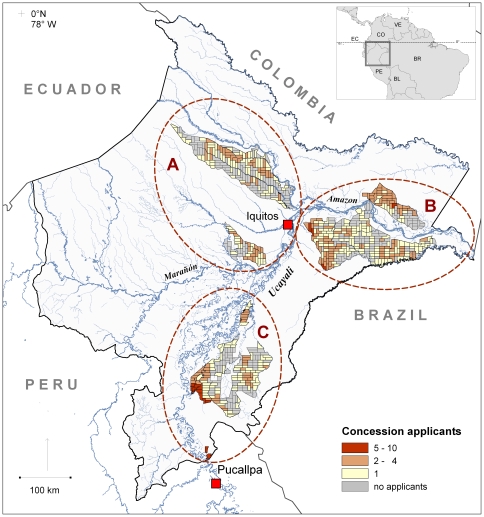
Forest concession units in Loreto, and the number of tenders (concession dapplicants) they received in the allocation process 2004.The cities of Iquitos and Pucallpa are marked with red squares. The concession Blocks are marked with dashed-line ovals indicated with letters A, B, and C.